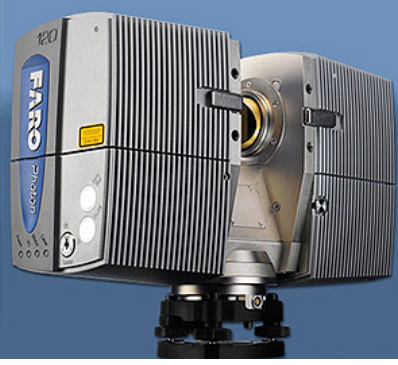
Figure 4: Left; A sample iPhone video frame from the building of interest. Right; Automacatically generated point cloud.